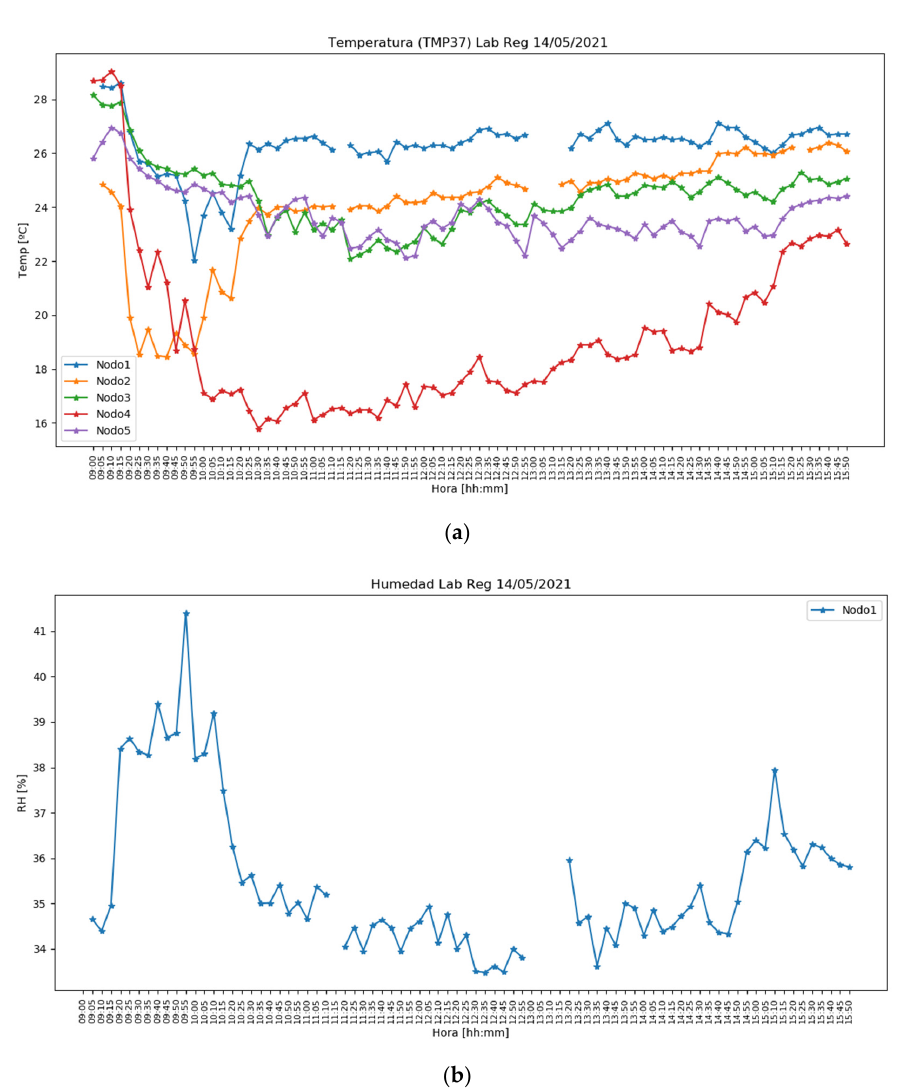
Figure 10. ( a ) Temperature measurements (TMP37); ( b ) Relative humidity measurements (SHT85).